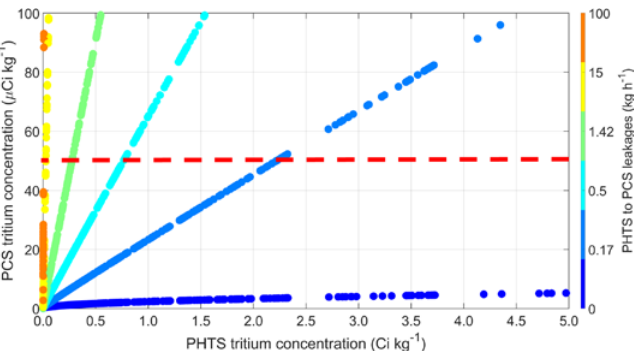
Figure 2. Tritium concentration in PCS for different leak rates from primary to secondary system, as a function of the tritium concentration in primary